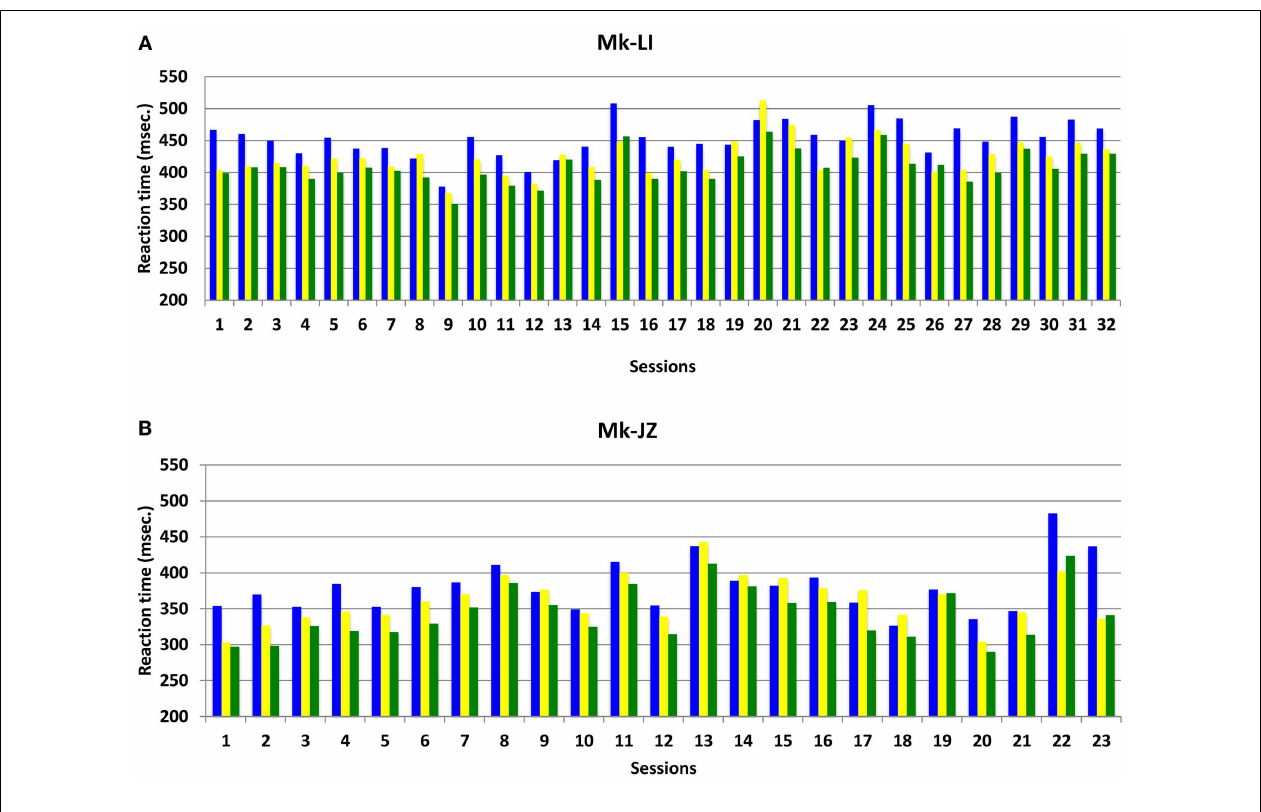
sessions in Mk-JZ), preceding the electrophysiological data collection. RTs in response to auditory stimuli are in blue, to visual stimuli in yellow and to both modalities delivered simultaneously in